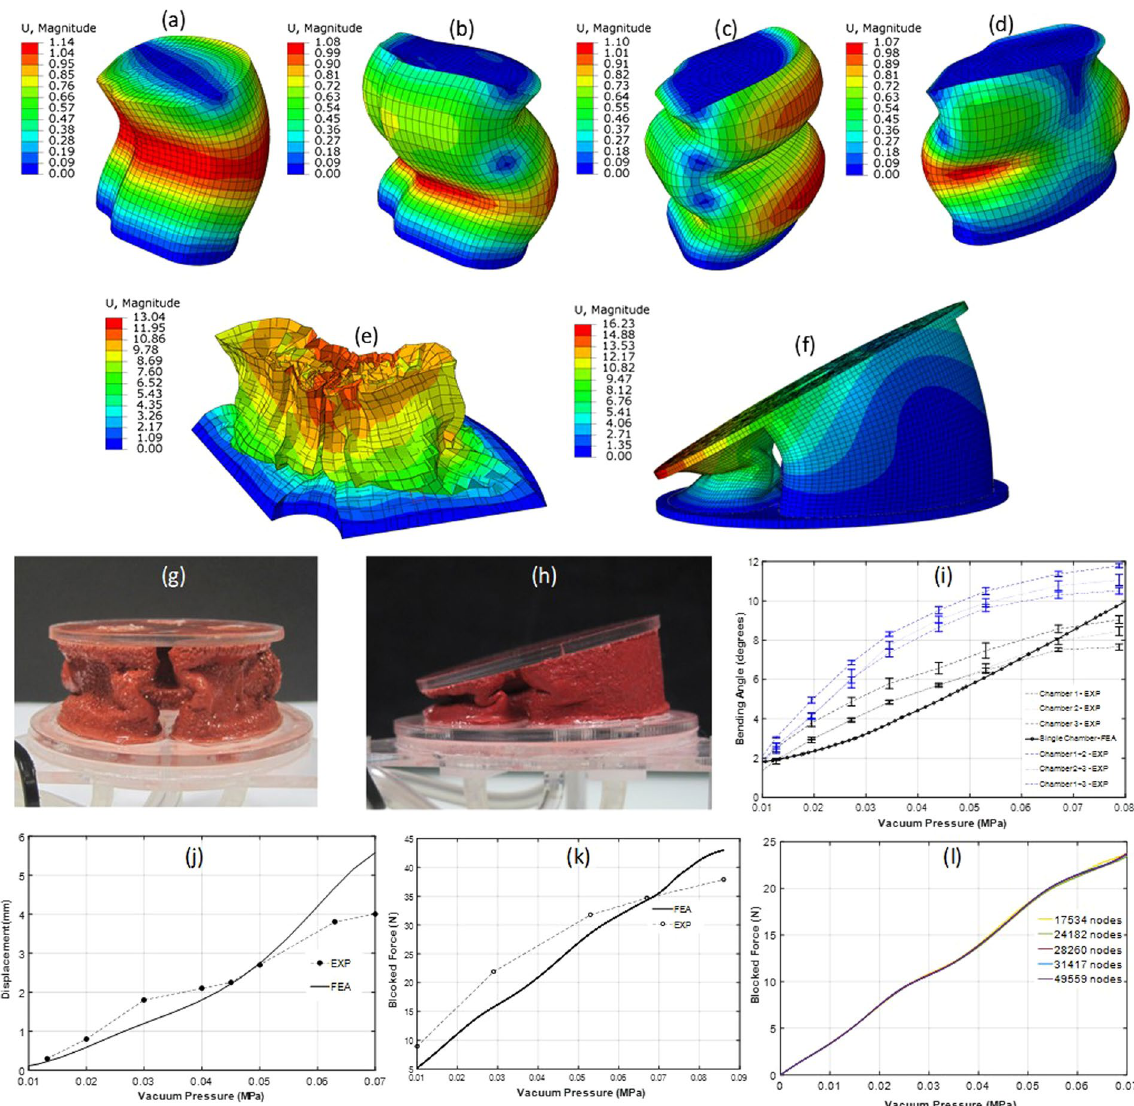
Figure 4. ( a – d) Different eigenmodes of buckling for a single foam chamber subjected to compression loading. (e) Post-buckling collapse of a foam chamber using explicit analysis. (f) Free displacement simulation of the entire V-SPA module under bending conditions, with two foam chambers pressurized. (g) Image of the module exhibiting linear displacement profile with all chambers subjected to vacuum pressure. (h) Image of module exhibiting bending motion profile with two chambers subjected to vacuum pressure. (i – k) Comparison of simulation and experimental results for bending, linear displacement and blocked force tests, respectively. (l) Mesh convergence test results with varying total number of nodes in the system comprising the V-SPA